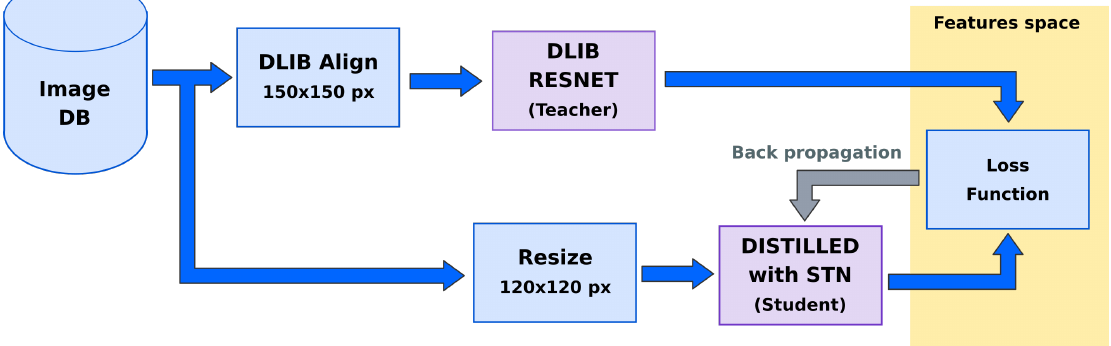
Figure 8. Proposed system with Dlib Resnet as teacher and Distilled network with STN as